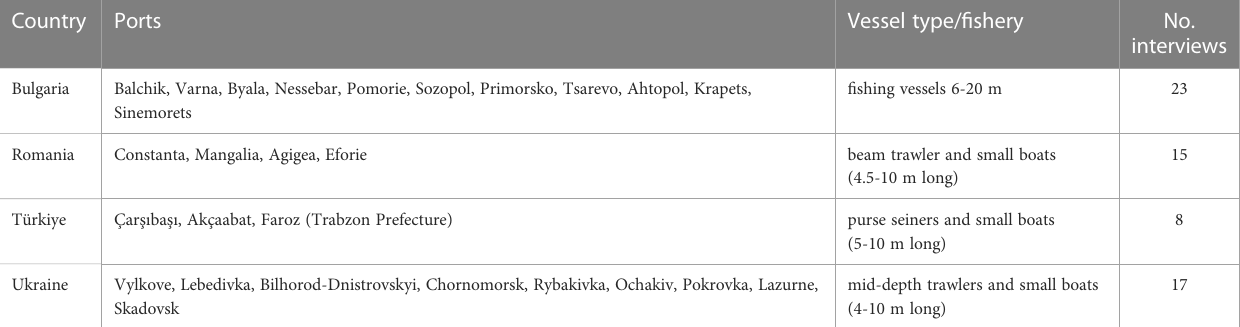
TABLE 1 Fishermen interviews by country and fi shing port. Country